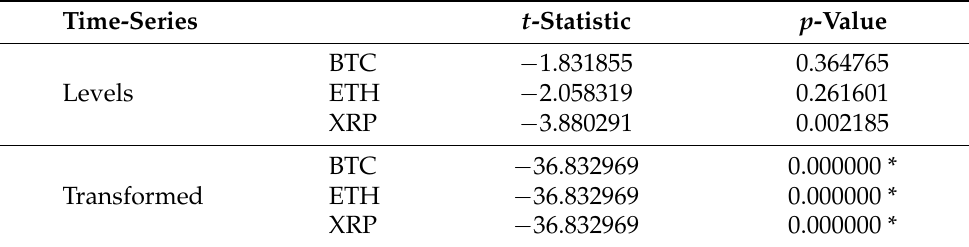
Table 3. Augmented Dickey–Fuller (ADF) unit root test of all cryptocurrency time-series.